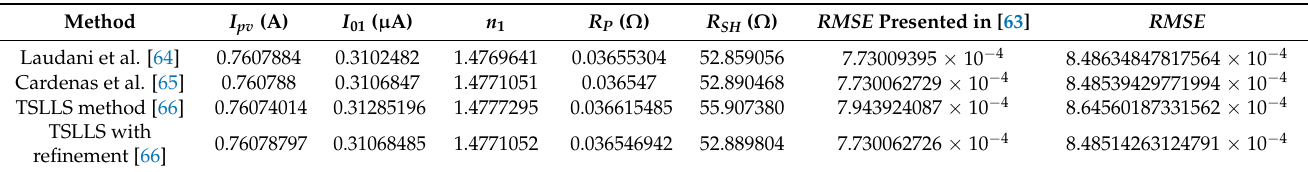
Table 3. Comparison with the deterministic methods described in [63–66] for the RTC France solar cell using different methods for both SDM and ISDM.